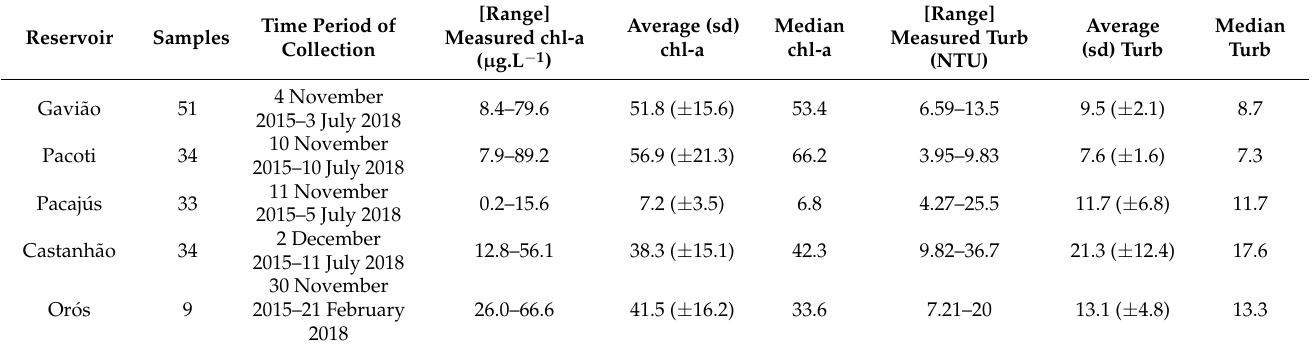
Table 2. Descriptive statistics (average combined with standard deviation—sd) of the chlorophyll-a (chl-a) and turbidity (Turb) parameters collected in the five reservoirs considered in this study. The chl-a data were used to calibrate the reflectance model to estimate chl-a from the Sentinel-2 images.